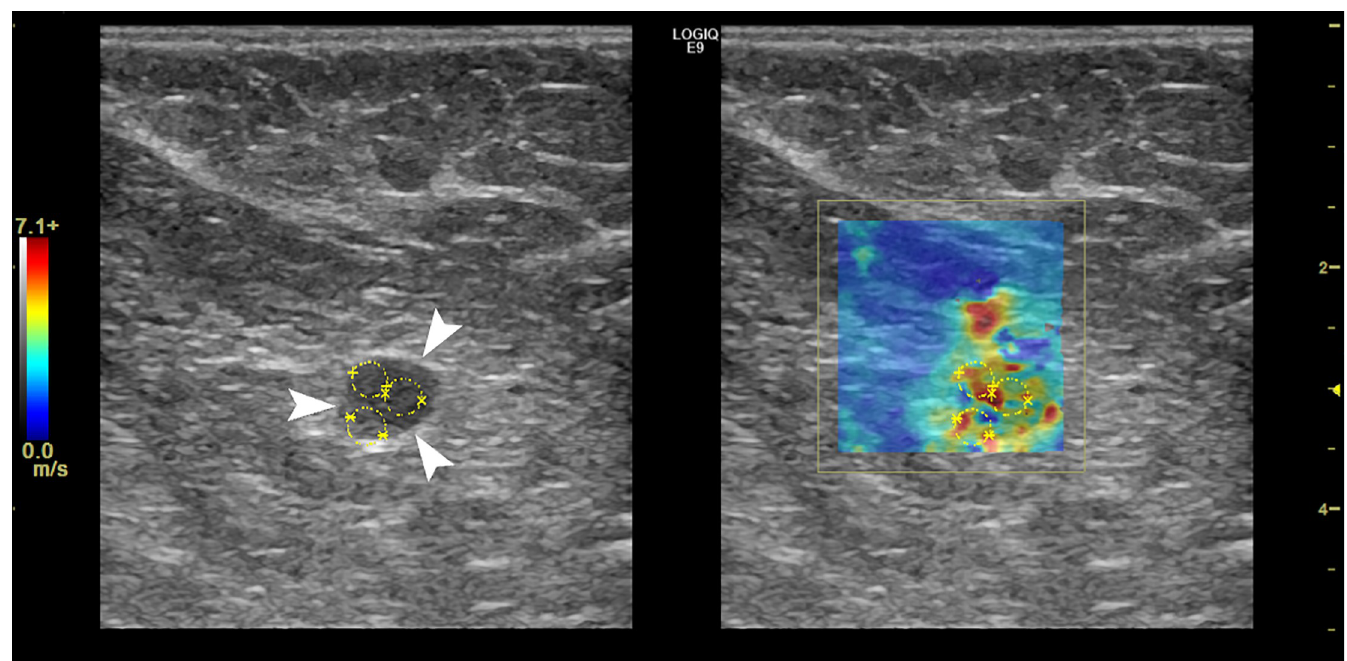
Fig 8. Right axillary B-mode (left) and shear wave speed map (right) images in a 61-year-old woman with invasive ductal carcinoma (grade II) in the right breast. The US image shows an abnormal, rounded lymph node (white arrows) with cortical thickening measuring 9-mm and absent fatty hilum. The elasticity results calculated from the average of the 3 ROIs (yellow) were E mean = 77.9-kPa and E max = 205.3-kPa. FNA biopsy result was positive for metastatic